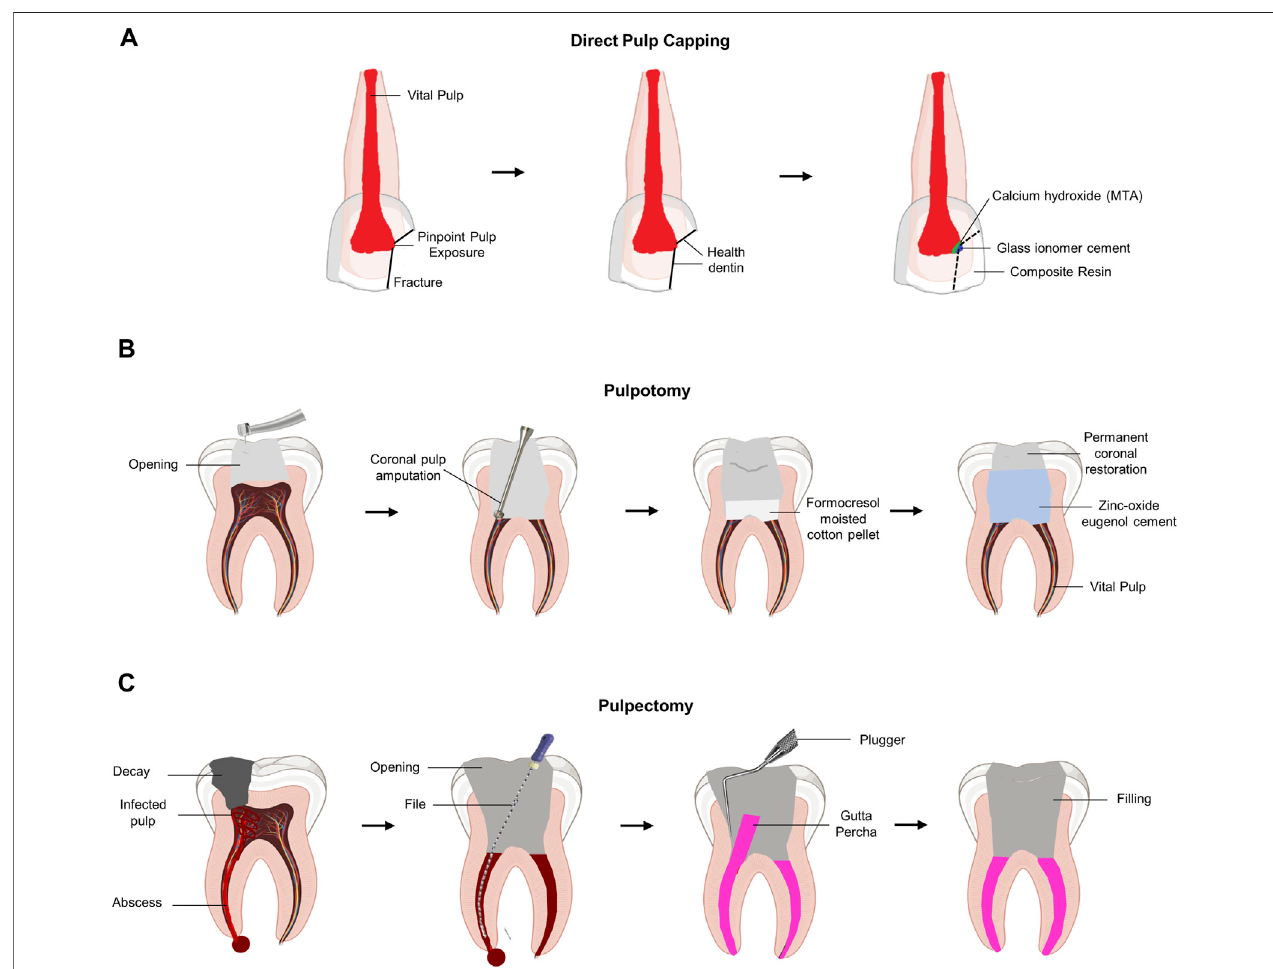
FIGURE 1 | Schematic diagram of the current concept of pulp therapy. (A) Direct pulp capping. Pulp capping is a method used to prevent necrosis of the dental pulpwhenitisslightlyexposedtothepin-point.Directpulpcappingcoverstheexposeddentalpulpwithabasethatprotectsthepulpandpreventsinfectiontomaintain dental pulp vitality. (B) Pulpotomy. Pulpotomy is a minimally invasive method that is clinically considered when there is pulpitis in the absence of root pathology. (C) Pulpectomy. Pulpectomy refers to a root canal treatment that removes irreversibly infected or necrotic pulp tissue.